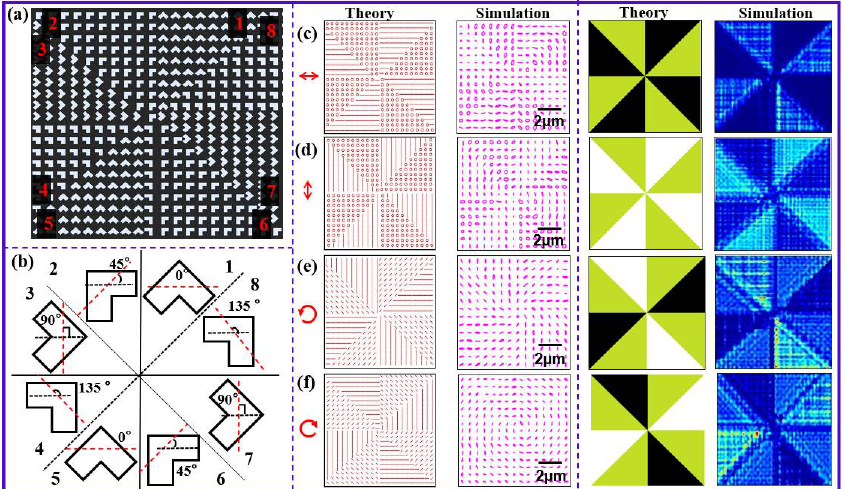
Figure 3. ( a , b ) Structures of metasurface integrated polarizer with four partitions, and ( c – f ) theoretical (at the first column) and simulated (at the second column) polarization distributions of the metasurface integrated polarizer. The patterns on two right columns represents the theoretical and simulated values of intensity in the y direction. The scale bar denotes 2 µm.